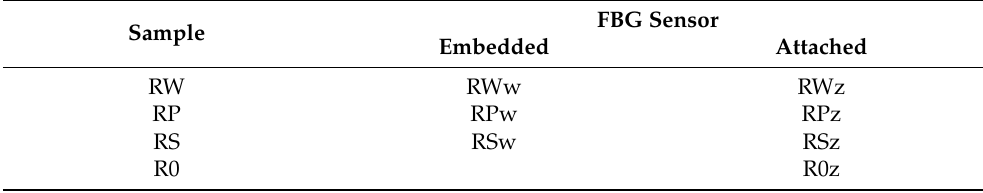
Table 5. Sensors